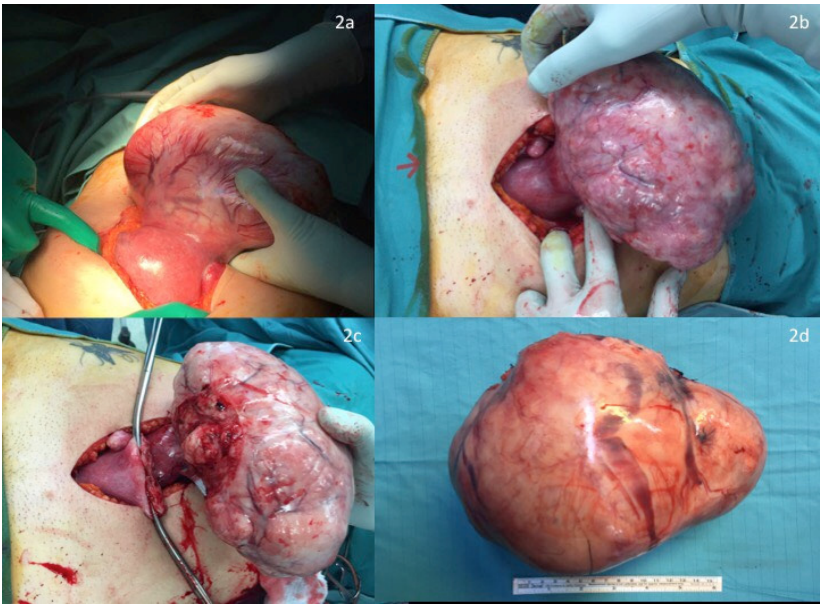
Figure 2. ( a , b ) Exteriorization of large mass after longitudinal laparotomy. ( c , d ) Surgical resection along the surface.